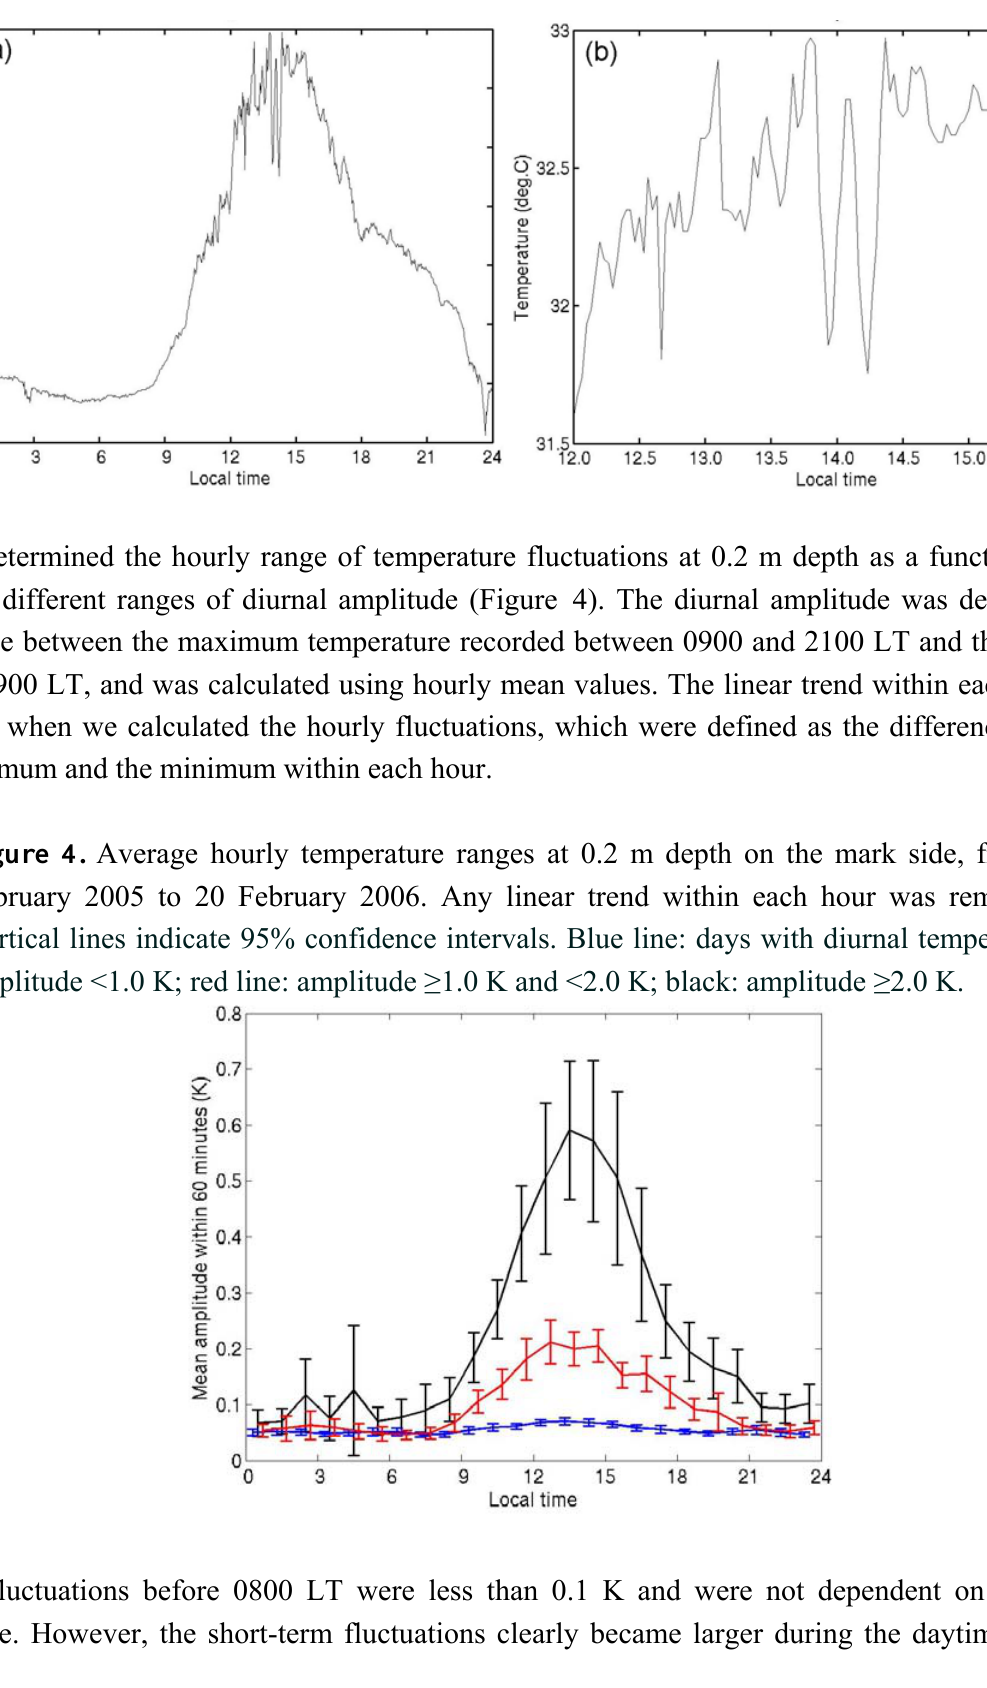
Figure 3. (a) Example of the temperature variation at 0.2 m depth on the mark side of the hull on 16 May 2005. (b) Enlargement of (a) showing the temperature from 1200 to 1600 LT.